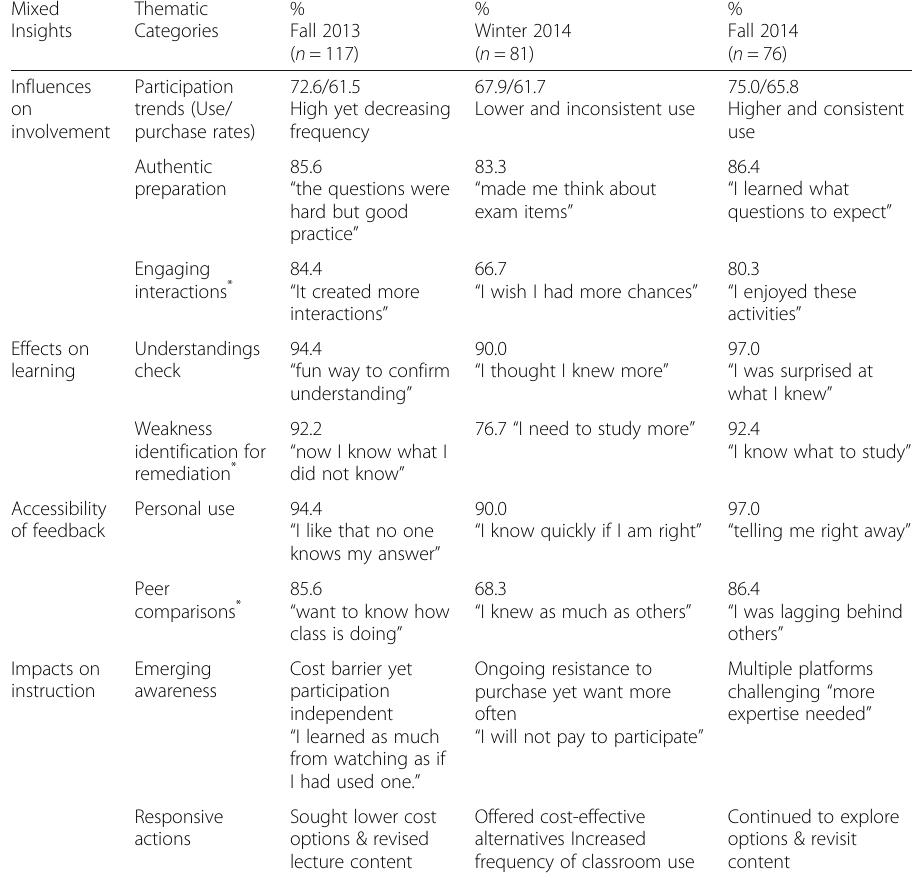
Table 2 Audience response systems joint display Mixed Thematic Insights